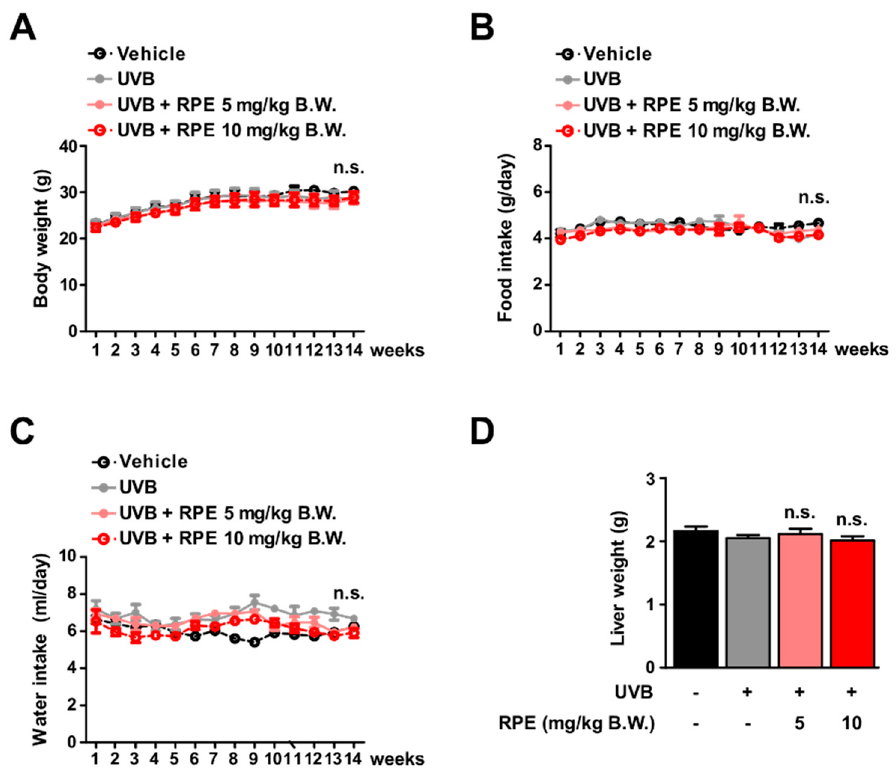
Figure 2. RPE does not show toxicity at the tested concentrations. ( A – C ) Body weight ( n = 7), food intake ( n = 4), and water intake ( n = 4) were measured twice a week. ( D ) Liver weight was measured after sacrificing the mice at the end of the experiment ( n = 7). Data represent the means ± SD. There was no significant difference (n.s.) among all groups.